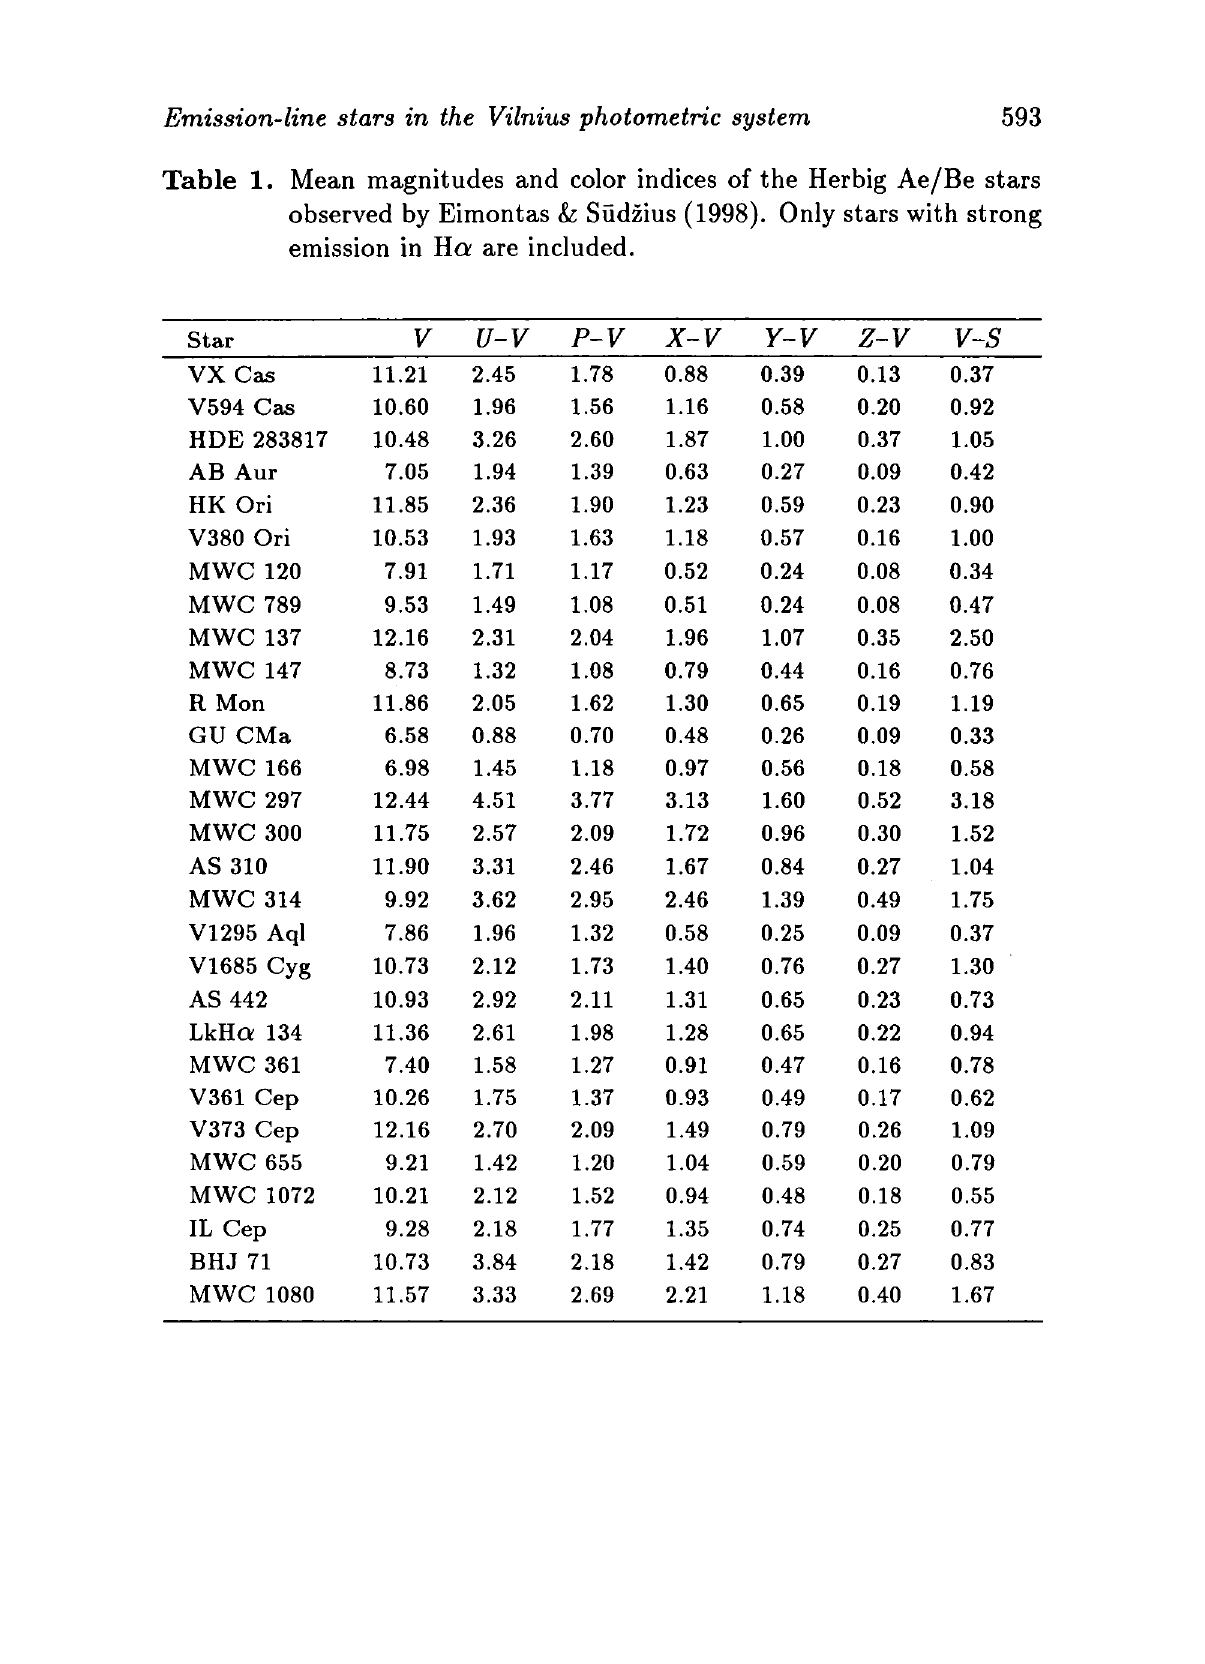
Table 1. Mean magnitudes and color indices of the Herbig Ae/Be stars observed by Eimontas L· Südzius (1998). Only stars with strong emission in Ha are